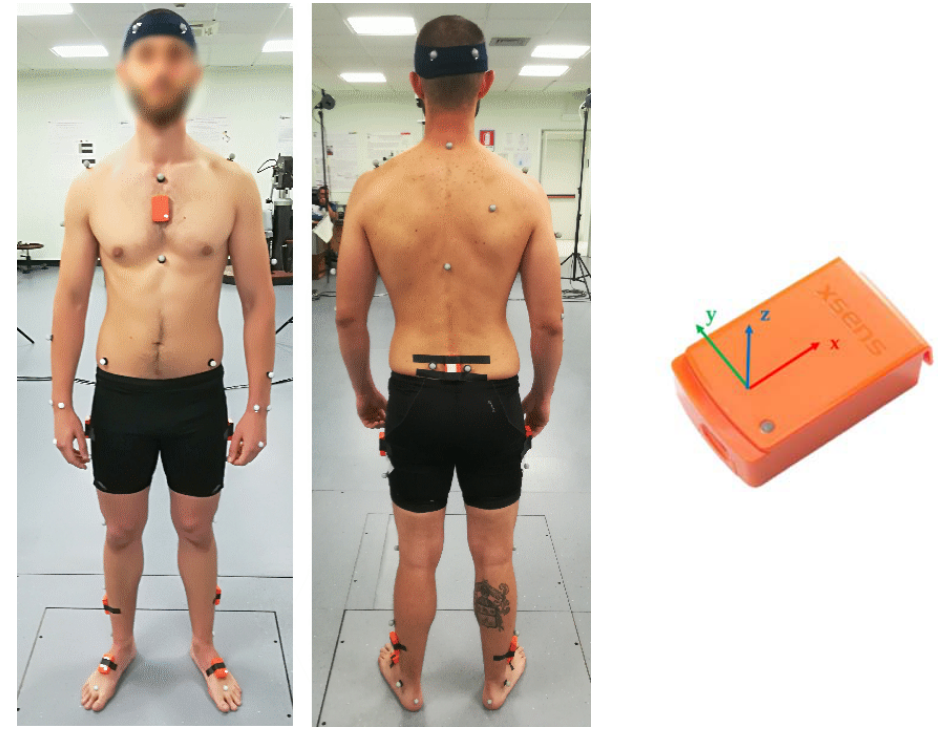
Figure 1. MIMUs and markers position on one subject as well as the inertial sensor reference system. Only the MIMUs placed on the pelvis and the lower limbs and the markers placed on the pelvis were considered in this study.